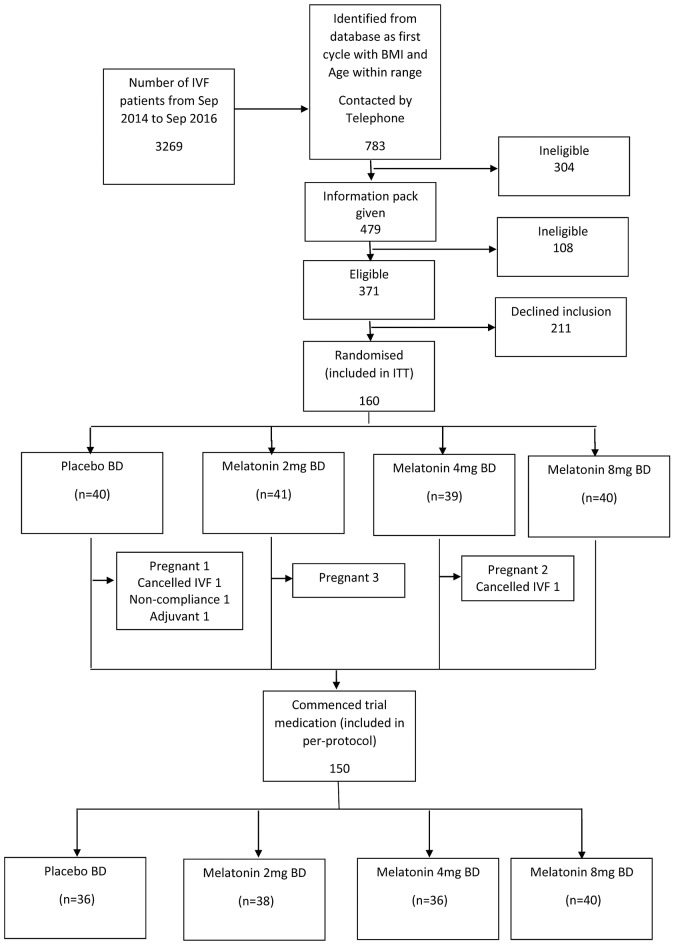
Recruitment flowchart. BD, twice per day; ITT, intention-to-treat; IVF, in-vitro fertilization.